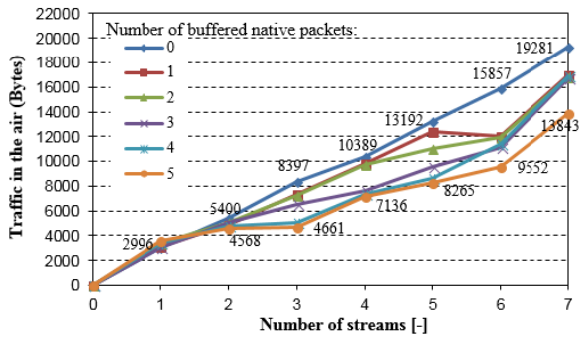
Figure 7. Overall traffic captured in the air (simple testing scenario)—number of buffered native packets = 0 means network without NC.